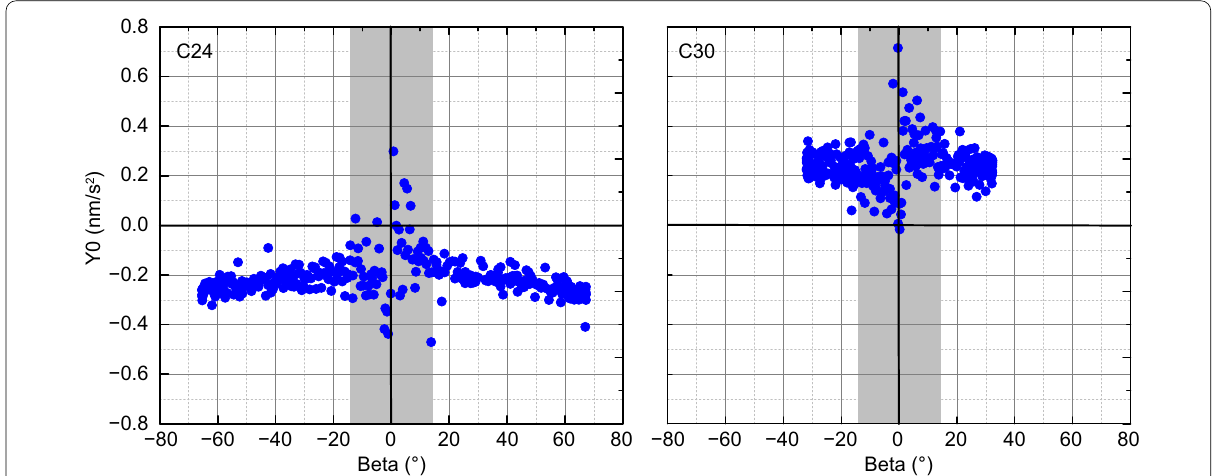
Fig. 11 Variations of Y 0 estimates for BDS-3 C24 (left) and C30 (right) satellites on β angle. Noticeable Y 0 bias is also identified for other BDS-3